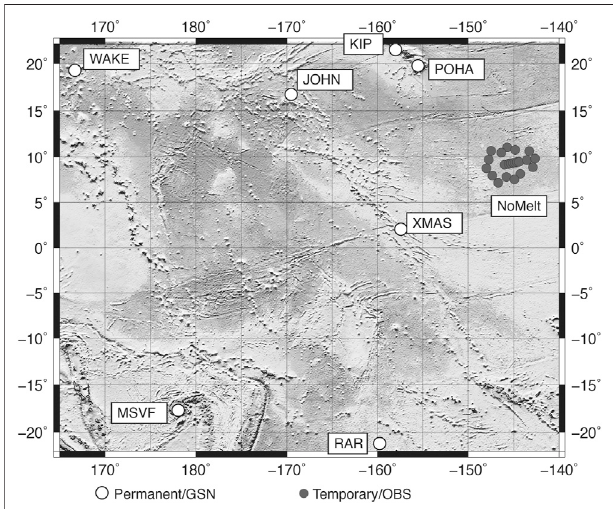
FIGURE10| Sitelocations ofthebroadband NoMelt OBSnetwork(Dec 2011 – Jan 2013). Also shown are sites of permanent observatory stations of the GSN: KIP (Kipapa, Oahu; primary sensor: STS-1), POHA (Pohakuloa, Hawaii; KS54000), JOHN (Johnston Island; KS54000), WAKE (Wake Island; KS54000), XMAS (Kiritimati Island, Kiribati; STS-2); RAR (Rarotonga, Cook Islands (KS54000); MSVF (Monasavu, Fiji; KS54000).